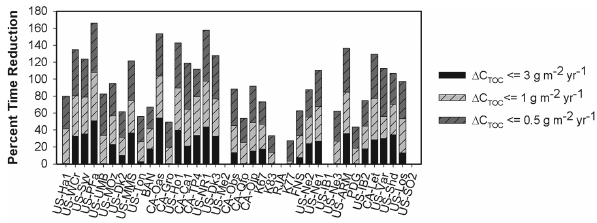
Figure 3. Stacked bar chart of percent reduction in computation cost for three convergence threshold